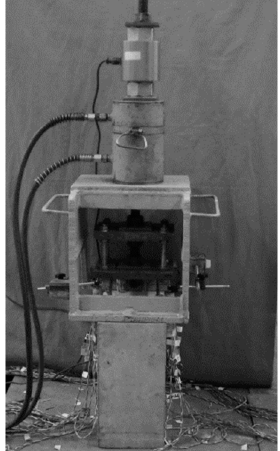
Figure 2. Test and measuring setup.